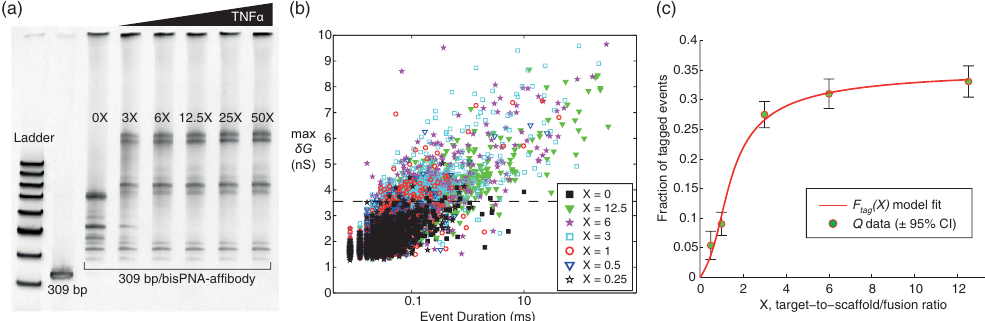
Figure 4. Measuring and modeling the fraction of tagged events as a function of TNF α -to-scaffold/fusion ratio, X . ( a ) EMSA assay shows increasing fraction of target-bound scaffold/fusion molecules as TNF α protein concentration increases, using a 309 bp/PNA-affibody detection reagent (Methods, Supplementary Fig. S27). ( b ) All-event scatter plot of max δ G versus duration for reagents with varying X . Each reagent was measured sequentially on the same 25–30 nm diameter pore (P29, Supplementary Table S52), with buffer only flushing and recording between reagent pairs. The number of events and recording periods for each reagent are: ( X = 0) N = 518 in 10 min; ( X = 12.5) N = 1222 in 10 min; ( X = 6) N = 1336 in 10 min; ( X = 3) N = 1565 in 10 min; ( X = 1) N = 819 in 10 min; ( X = 0.5) N = 350 in 4 min; and ( X = 0.25) N = 690 in 10 min. Using the X = 0 reagent to establish the tagging criteria max δ G > 3.56 nS (dashed line), all X > 0 values were positive with 99% confidence above a false positive of 2%, with the exception of X = 0.25 which was not positive. The time to positive (TTP) values: X = 12.5 in 6 sec; X = 6 in 5 sec; X = 3 in 10 sec; X = 1 in 41 sec; and X = 0.5 in 2.3 min. ( c ) The positively detected data in ( b ) were subsequently modeled using the three-parameter model F tag ( X ), resulting in parameter values ( α , q 1 , q 2 ) = (0.35, 0.17, 0.11) and NRMS fitting error of 3.8% (Supplementary Table